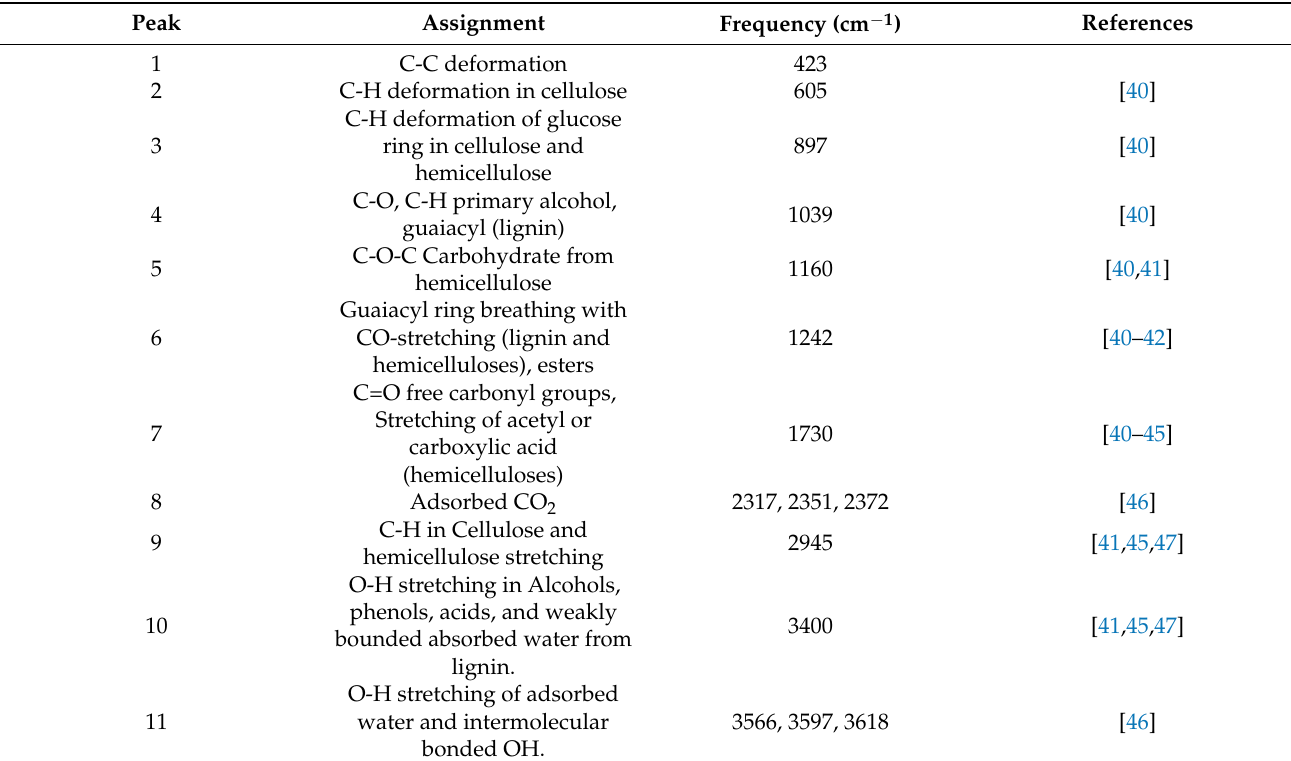
Table 2. Characteristic bands of FTIR spectra of bamboo samples in the frequency interval of 400 to 3600 cm − 1 .